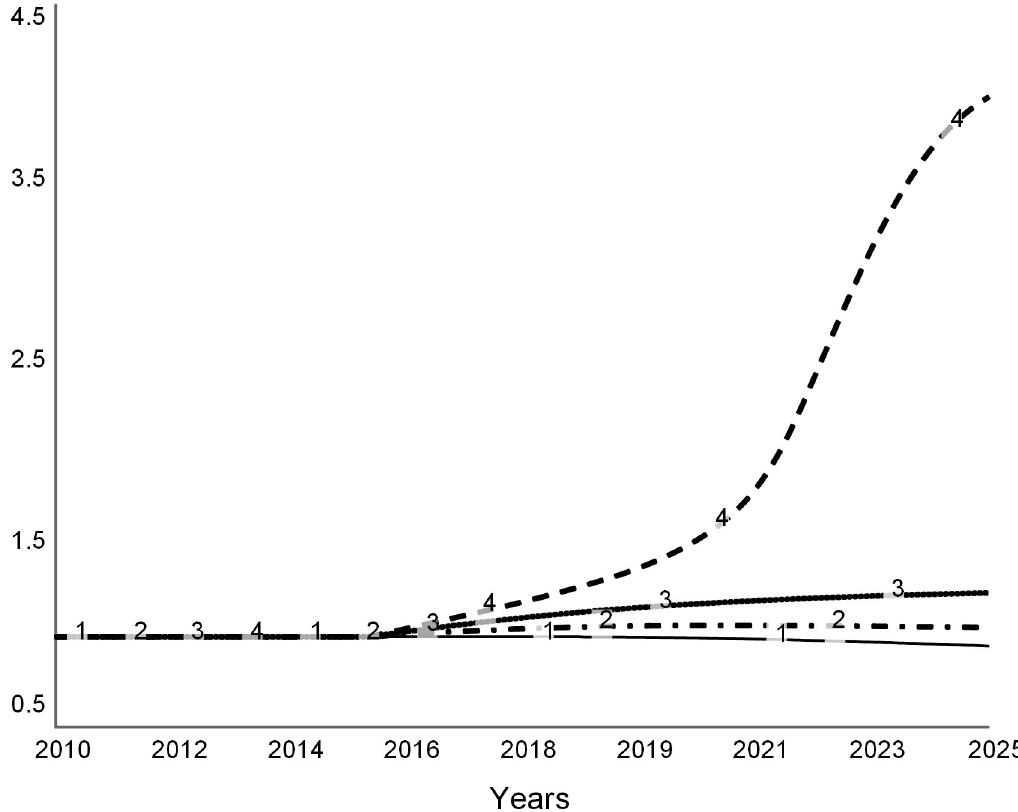
Fig 14. Faculty load increases as the college hires fewer faculty. Curve 1 is the base run: all searchers are allowed. Curve 2: 75% of searches allowed. Curve 3: 50% and Curve 4: 25% of searches allowed.